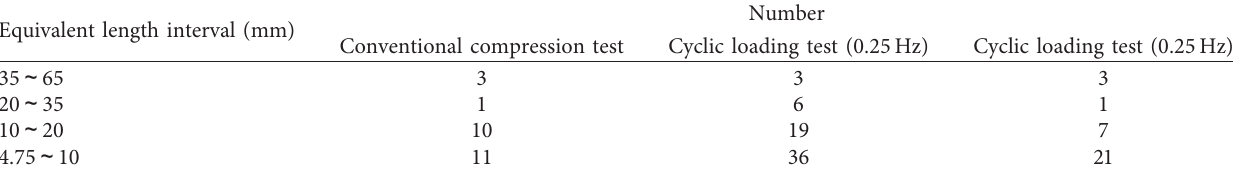
Table 6: Equivalent length interval and quantity under the uniaxial stress state.